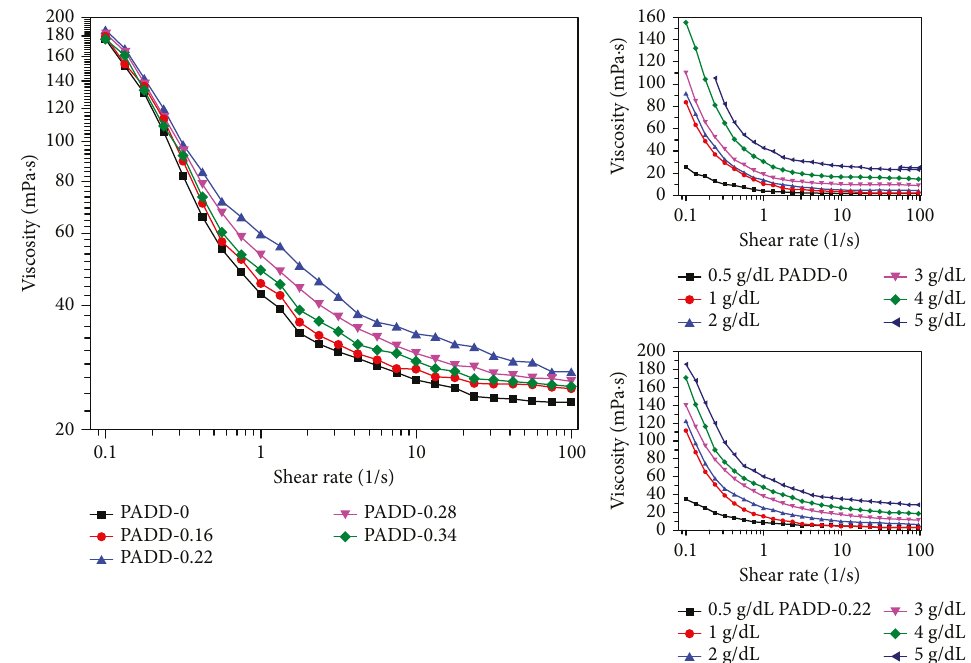
Figure 3: Variation of the apparent viscosity of polymer solutions in brine (25.0 ± 0.1 ° C; 5 g/dL